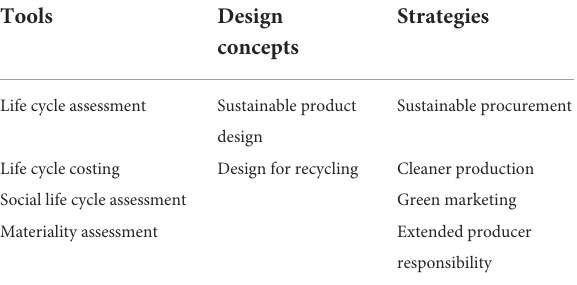
TABLE 1 Life cycle management tools, design concepts, and strategies.